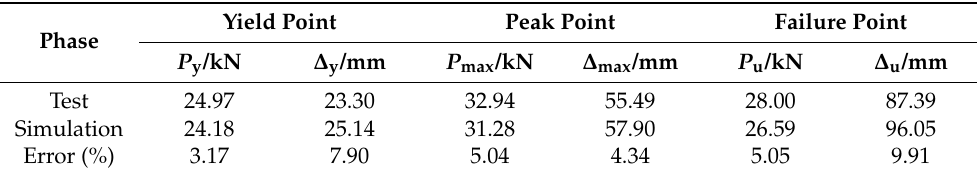
Table 5. Parameters of C-1 specimen.